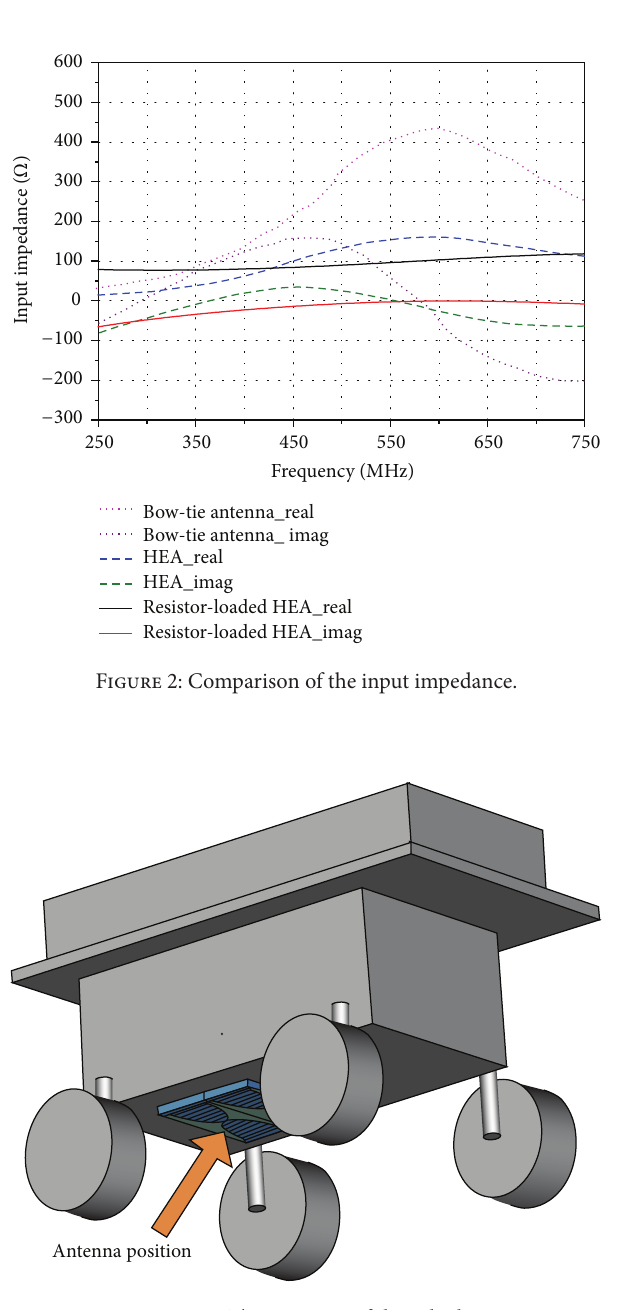
Figure 3: The structure of the vehicle.